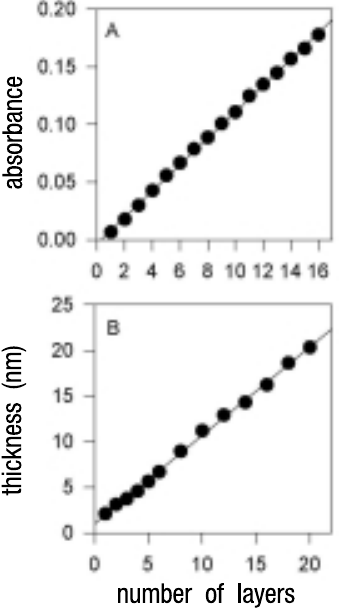
Fig. 1–(A)AbsorbanceofaDPNfilm(at360nm)asafunctionof the number of deposited layers on both sides of a glass substrate. (B) Ellipsometric thickness of a DPN film as a function of the number of layers deposited on one side of a silicon